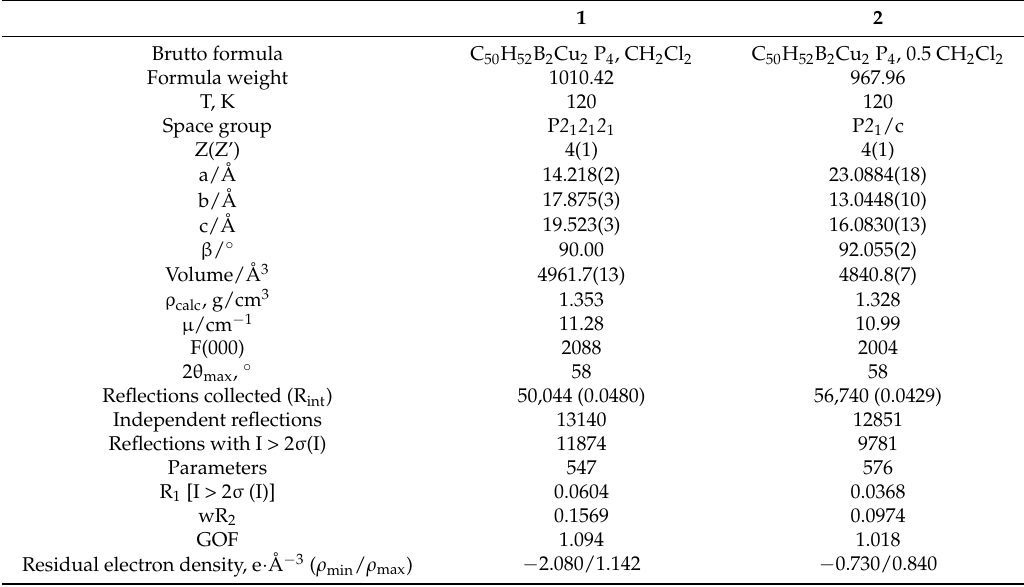
Table 1. Crystal data and structure refinement parameters for 1 and 2